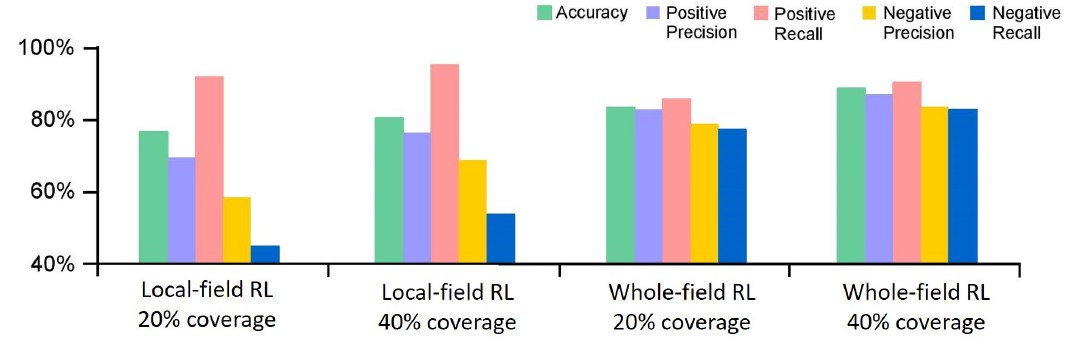
Figure 5. Accuracy of maps generated by autonomous scouting at different coverage